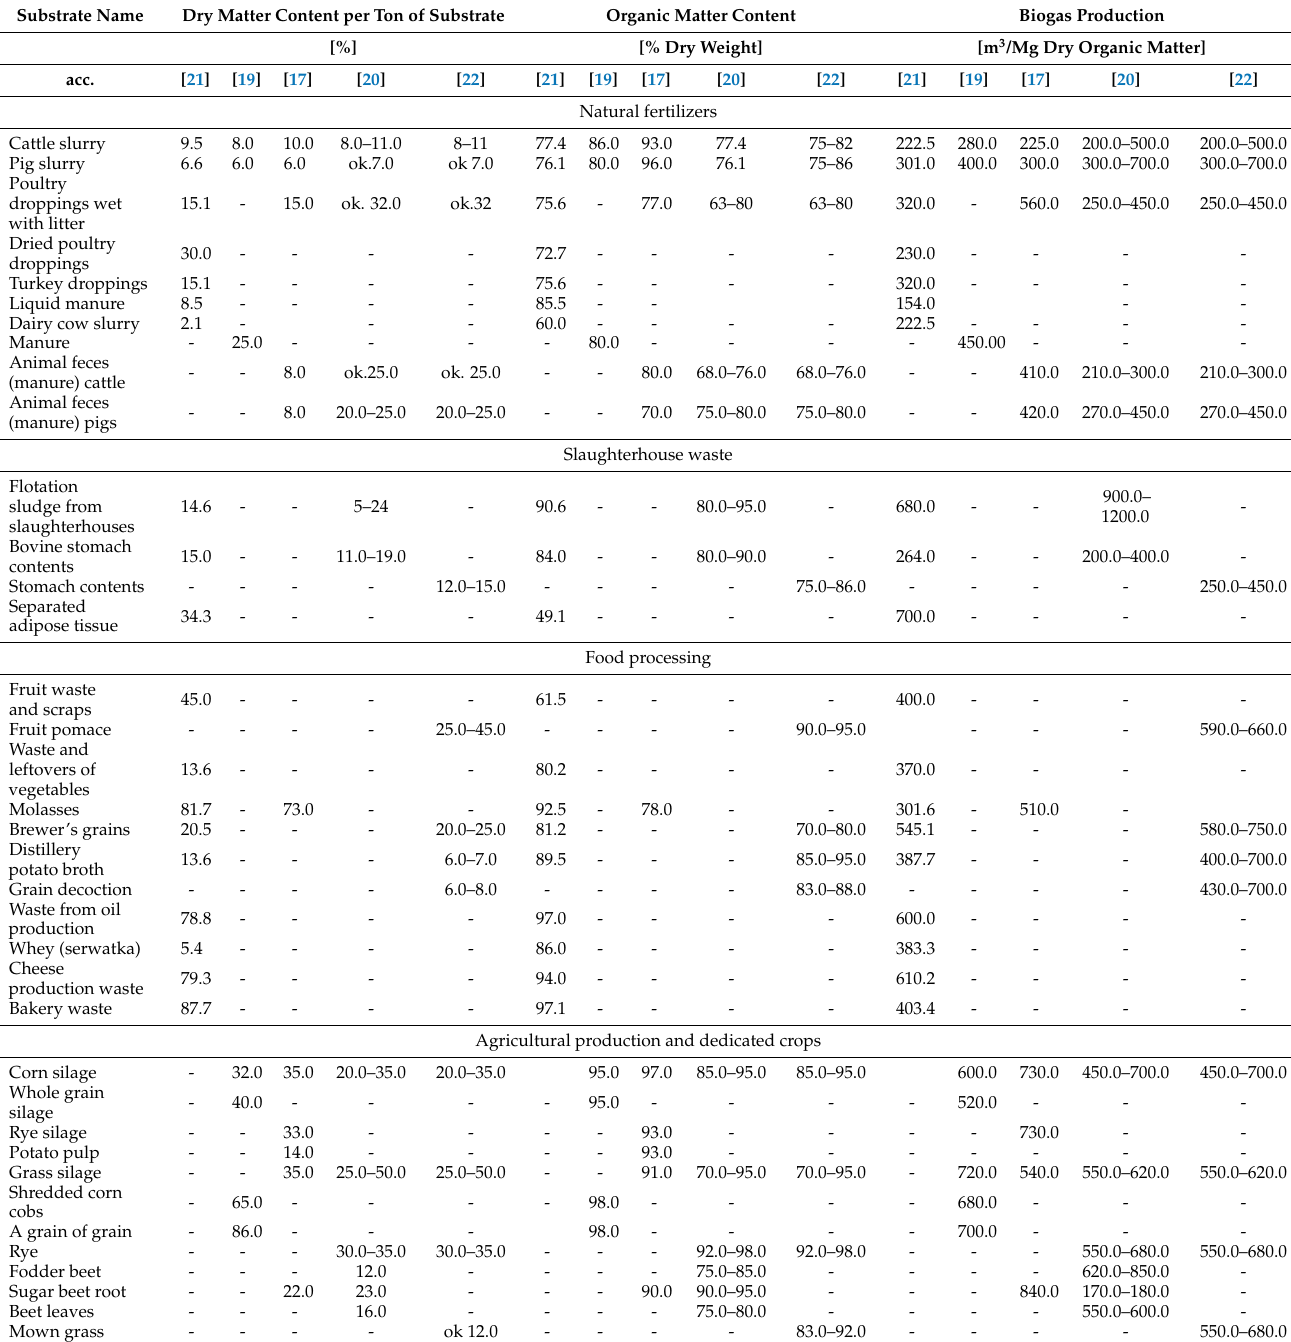
Table 2. The potential of biomass as a source of energy in Poland (own